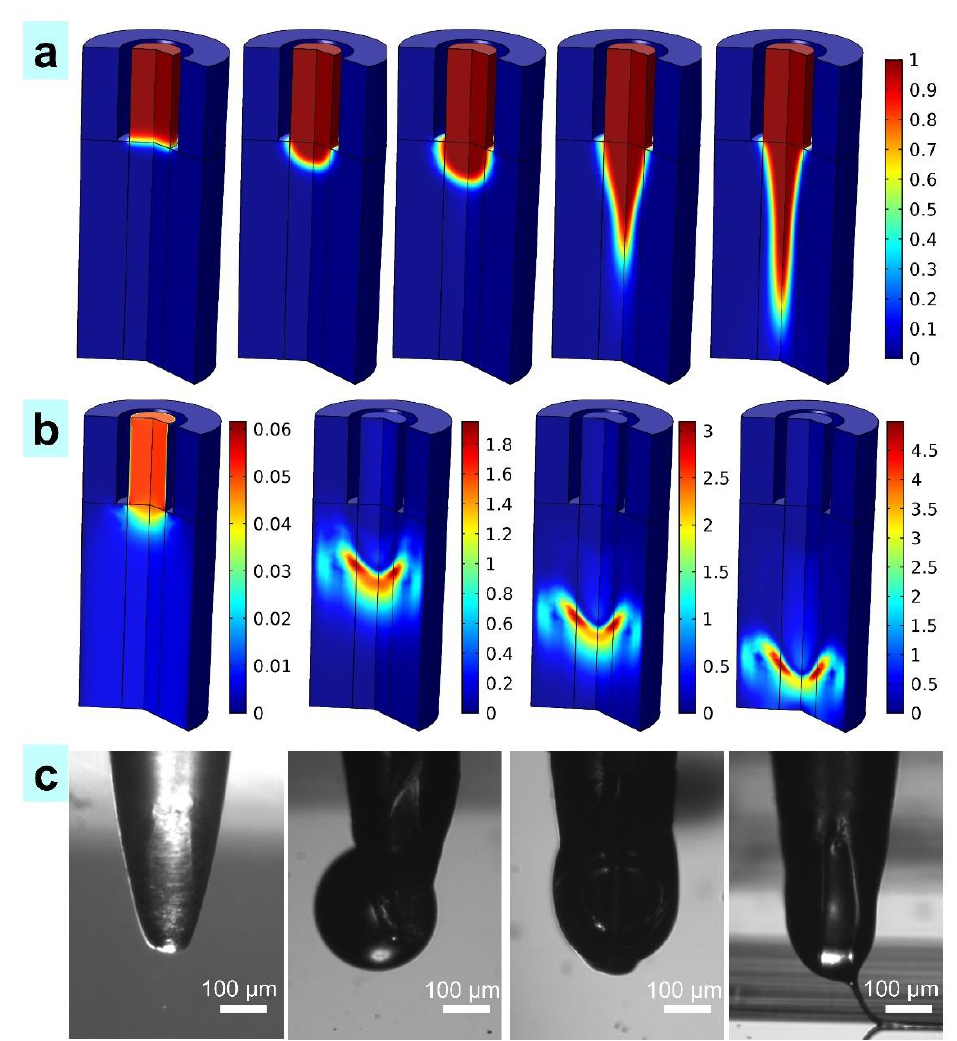
Figure 4. The formation of a viscous jet. ( a ) The simulation results of the viscous jet (0 µs, 2 µs, 4 µs, 6 µs and 8 µs, respectively); ( b ) Jet speed, 2 µs, 4 µs, 6 µs, and 8 µs, respectively (unit, mm s −1 ); ( c ) The experimental process of the viscous jet (scale, 100 µm).